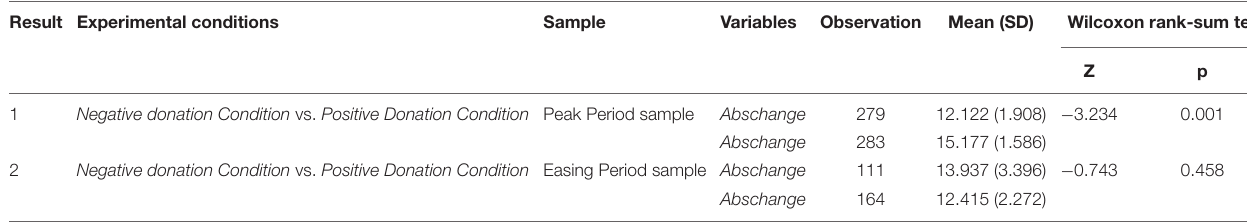
TABLE 4 | Contagion of donation behaviors according to the change amounts in the participants’ donation decisions. Result Experimental conditions Sample Variables Observation Mean (SD) Wilcoxon rank-sum